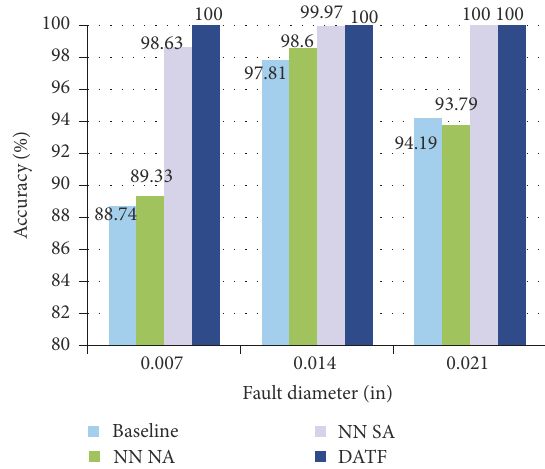
Figure 6: The results with fault size being 0.021in.